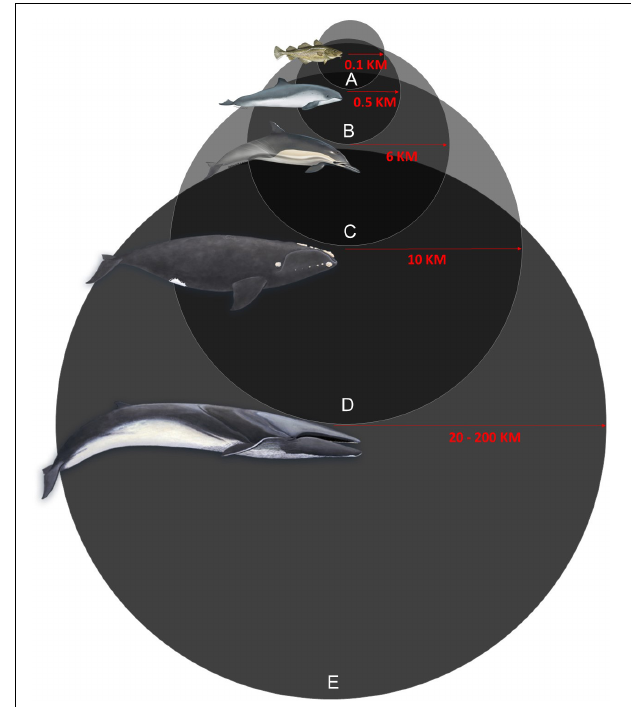
FIGURE 4 | This figure provides a stylized example of the average acoustic detection ranges of varying categories (A–E) over which different species groups and representative call types for each can be heard. Detection range A covers 0.1 km and includes sounds such as Atlantic cod ( Gadus morhua ) grunts. Detection range B covers up to 0.5 km and includes harbor porpoise ( Phocoena phocoena ) clicks and other fishes. Detection range C covers up to 6 km and generally includes dolphin species whistles. Detection range D covers up to 10 km and includes vocalizations of baleen whale species such as North Atlantic right whale ( Eubalaena glacialis ) upcalls and sperm whale ( Physeter macrocephalus ) clicks. Detection range E covers a range from 20–200 km and represents vocalizations of other baleen whale species such as blue whale ( Balaenoptera musculus ) and fin whale ( Balaenoptera physalus ) song. Circles sizes are not to